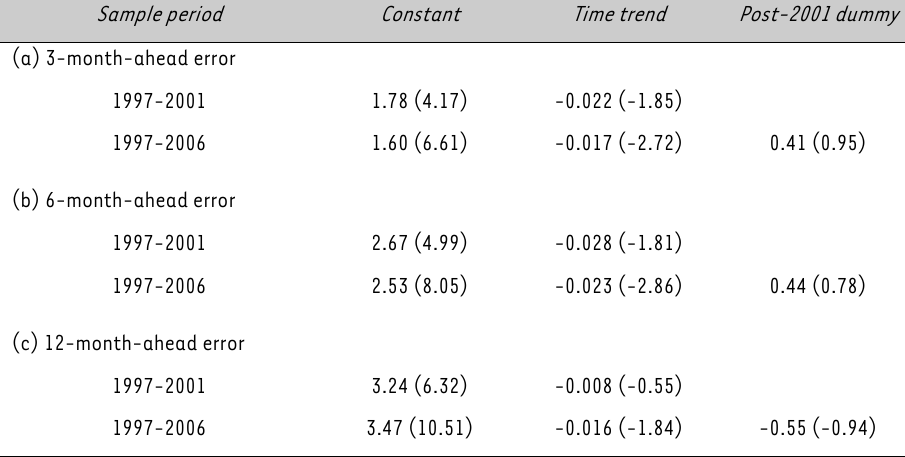
TABLE 3: JIBAR Forward Market Forecast Errors, 1997:1-2006:12, (monthly